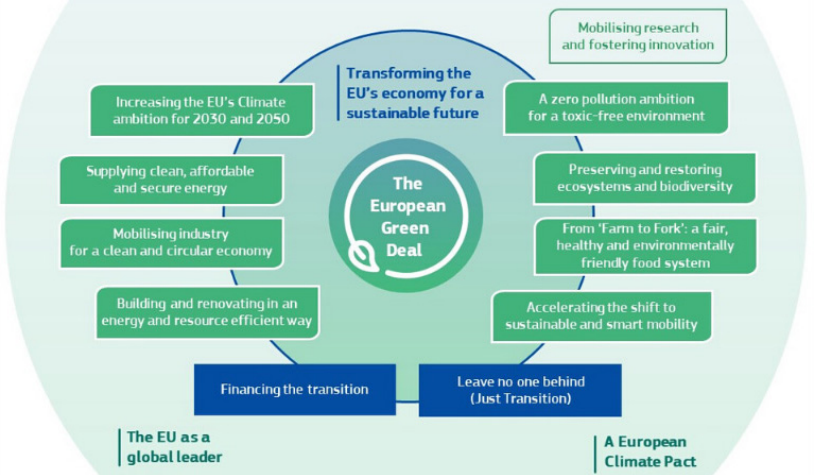
Figure 3. The concept of the European Green Deal (source: [18]).